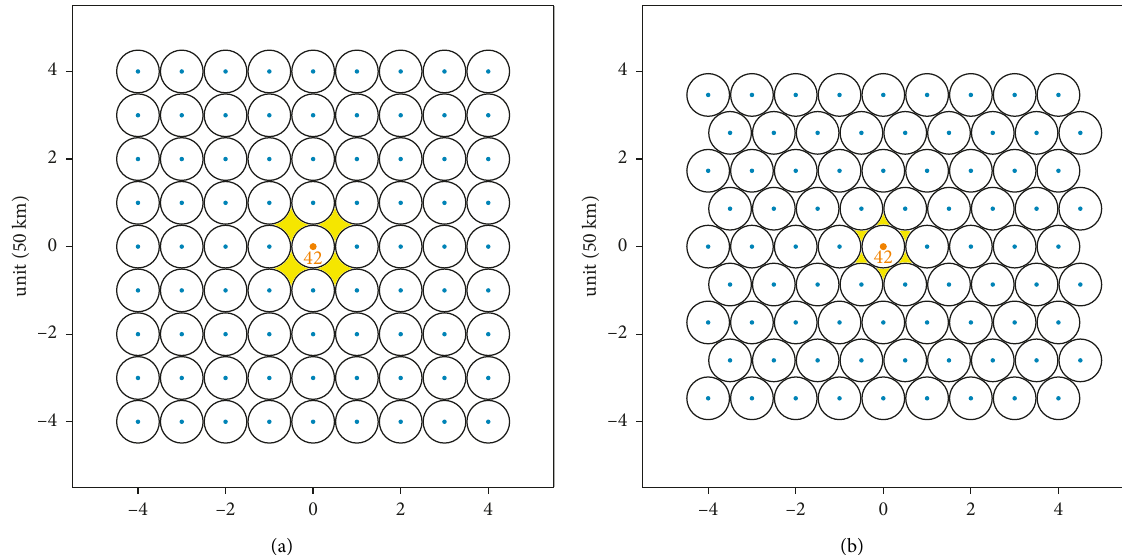
Figure 5: Distributions of candidate positions of the new navigation station. The center point is node 42 in the original network. (a) Vertical and horizontal arrangement. (b) Staggered arrangement.